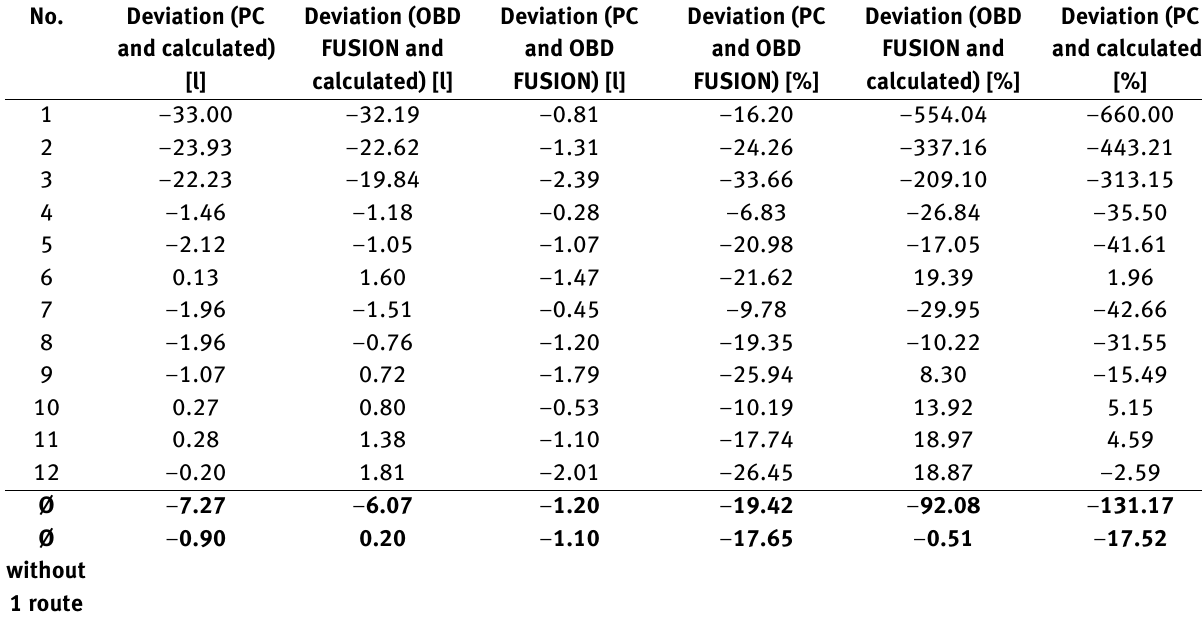
Table 8: Comparison of the first investigation deviation values in relation to fuel consumption of compression ignition engine